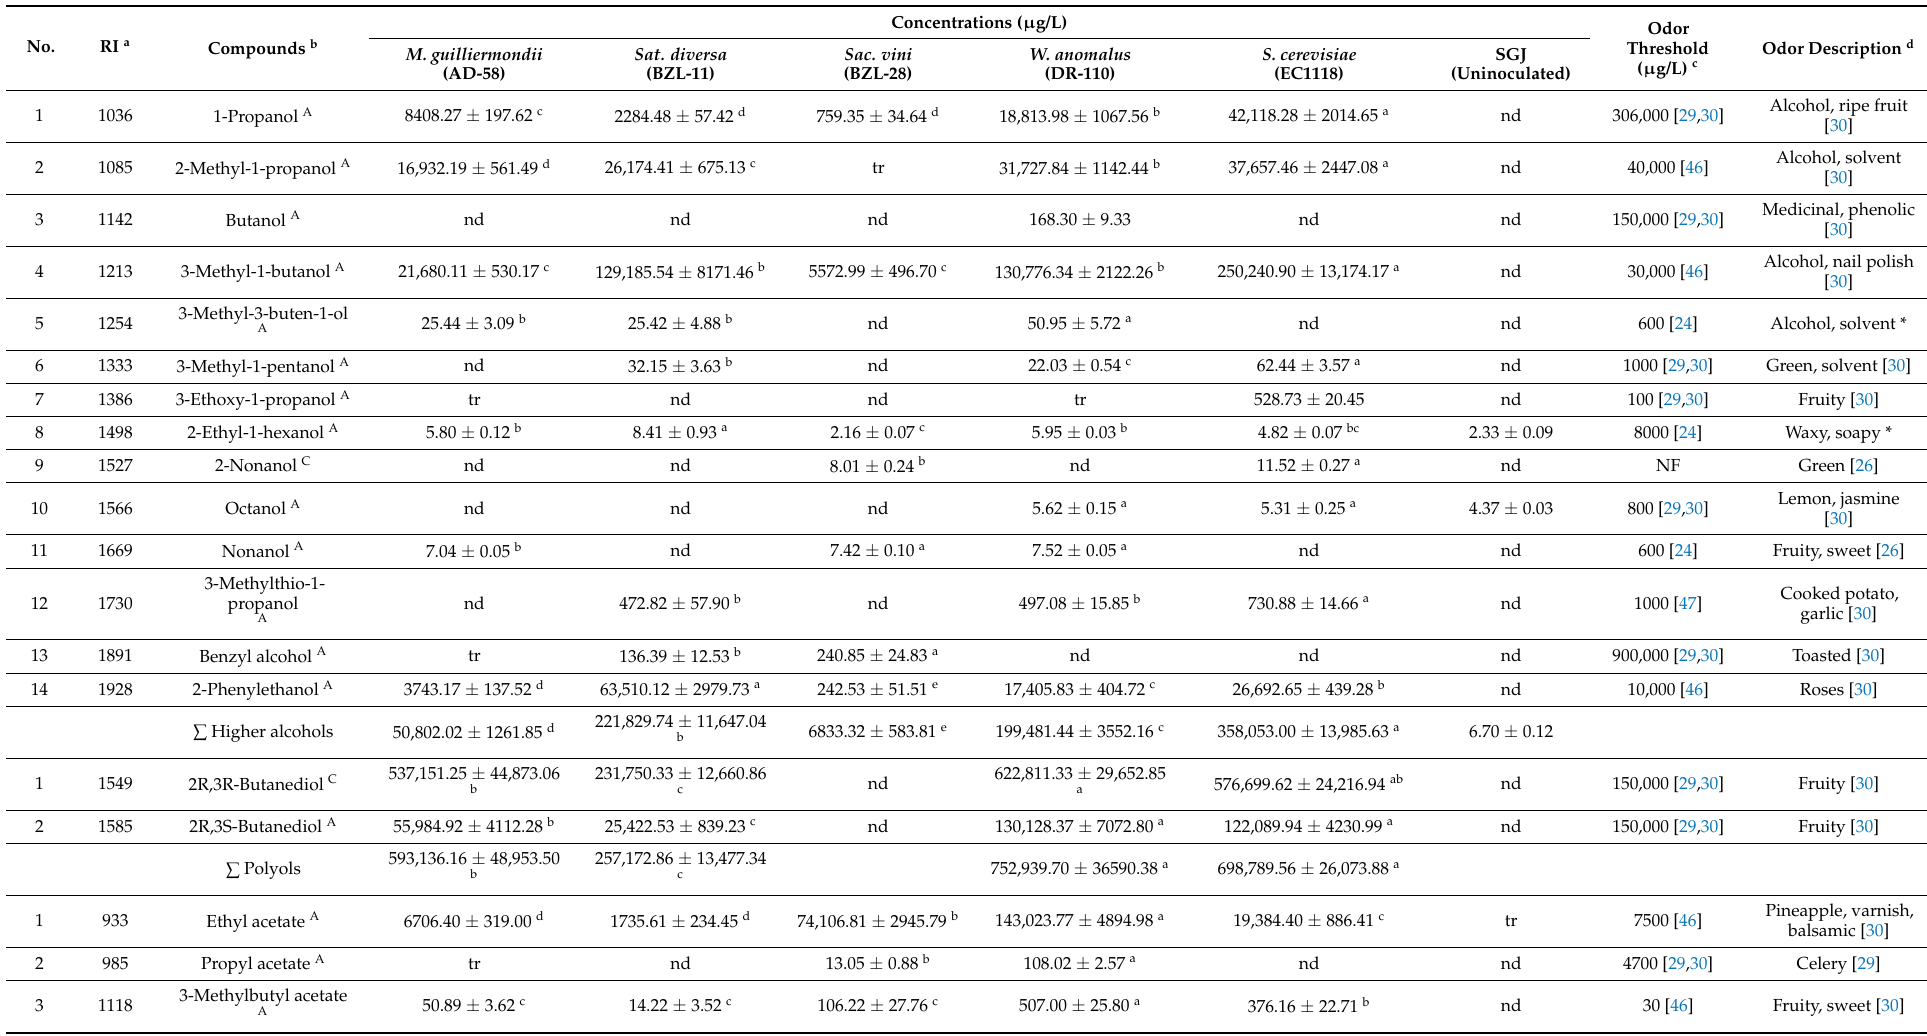
Table 2. Concentrations of volatile aroma compounds in five fermented media and SGJ (mean ±